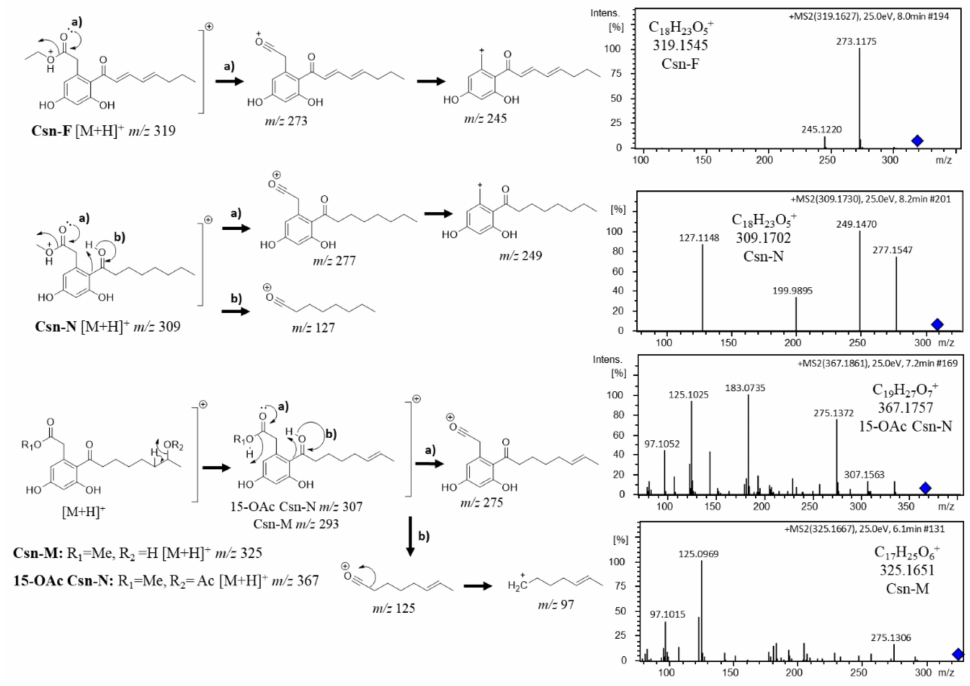
Figure 3. Octaketide (Csn) annotations based on ESI-(+)-HRMS-MS fragmentation mechanisms. The blue diamond in MS 2 spectrum represents the precursor